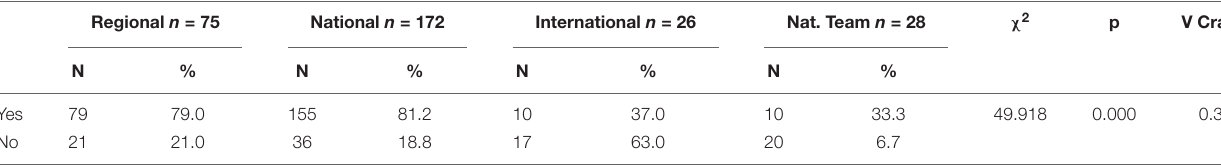
TABLE 2 | Coaches answers on gymnasts dropping out the sport during confinement.